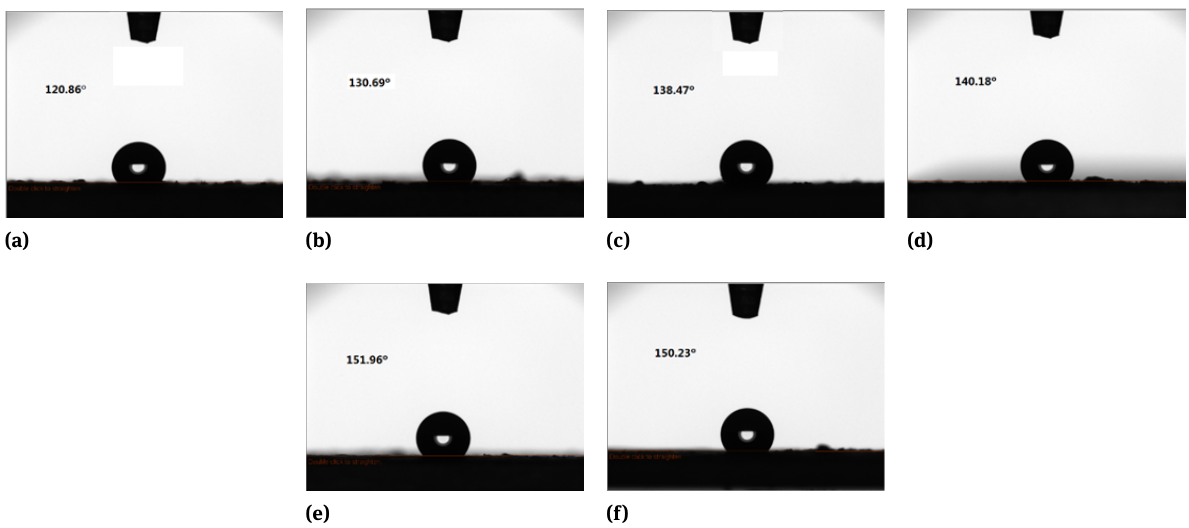
Figure 17: The contact angle of UV curable hybrid coatings with different composite particles content: a) 0%; b) 3%; c) 6%; d) 9%; e) 12%; f)